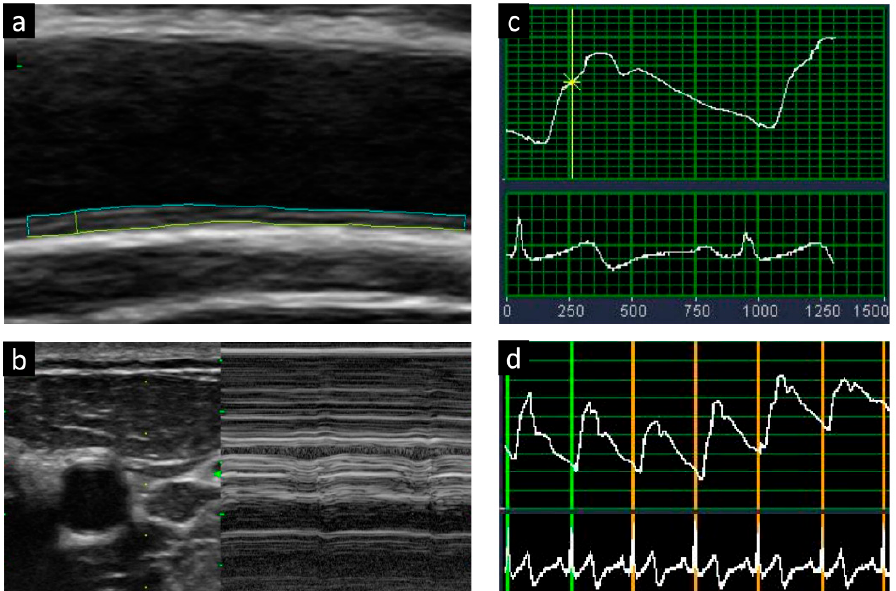
Figure 1. Measurements of carotid intimal media thickness ( a , b ) and arterial stiffness with the use of beta-index ( c , d ).